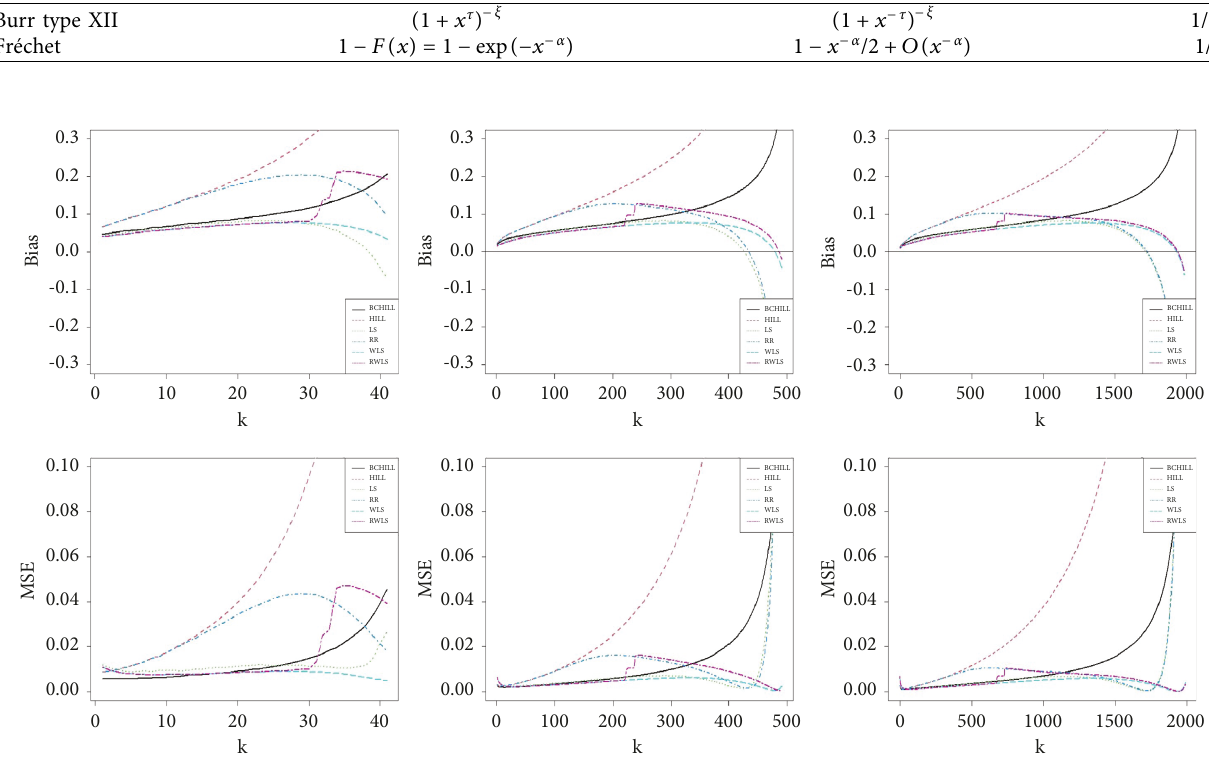
Figure 1: Results for Burr type XII distribution with c � 0 . 1: Bias (top row) and MSE (bottom row). First column: n � 50; second column: n � 500; and third column: n � 2000.